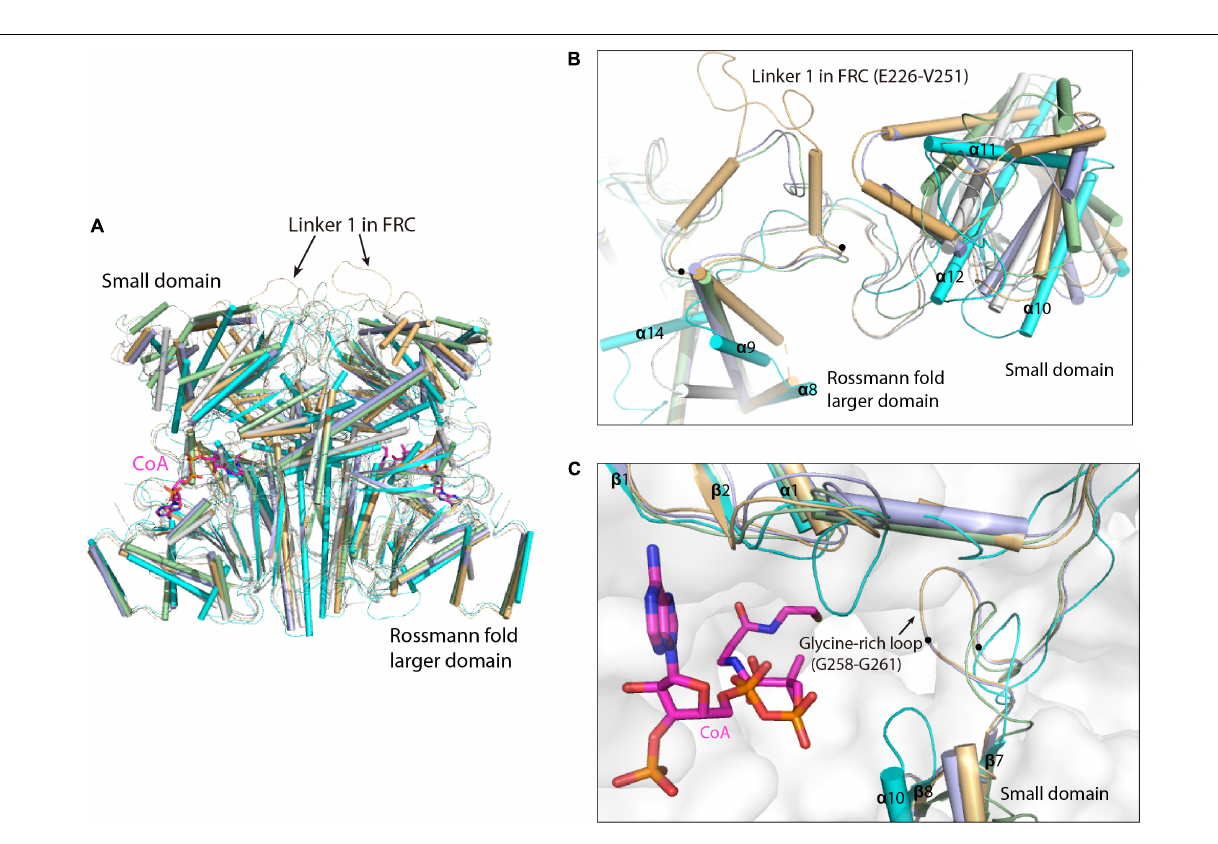
Frontiers in Microbiology |